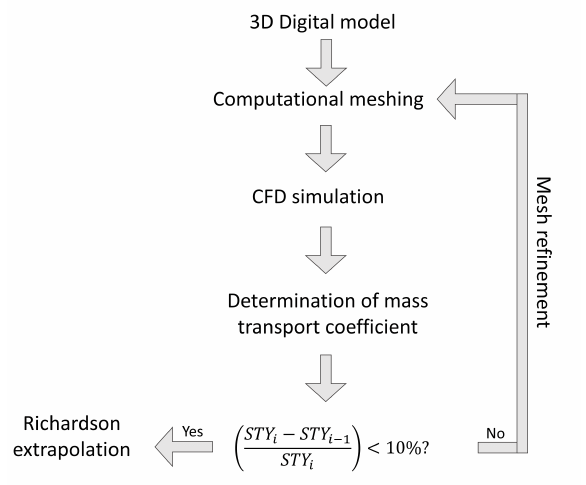
Figure 5. Computational convergence procedure to determine STY .